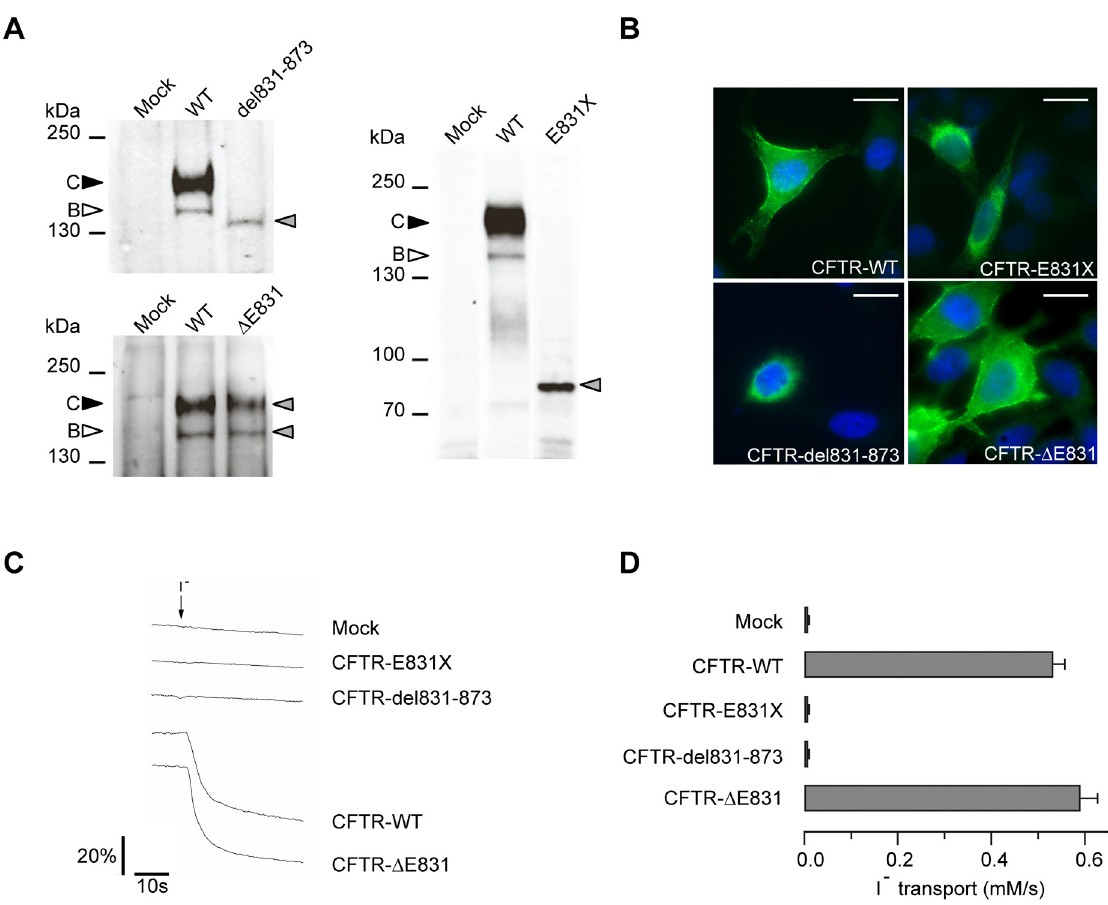
Figure 5. Characterization of the three CFTR mutant proteins. (A) Western blot analysis of HEK293 cells transiently transfected with CFTR-WT, CFTR-del831-873 (upper left panel), or CFTR- D E831 (lower left panel). Western blot analysis of HEK293 cells stably expressing CFTR-WT or CFTR-E831X (right panel). Filled and empty arrowheads indicate the fully-glycosylated (170 kDa) and core-glycosylated (140 kDa) CFTR, respectively. Grey arrowheads indicate mutant proteins. (B) Immunostaining performed on HeLa cells transiently transfected with the indicated constructs. CFTR was stained with MM13-4 anti-CFTR and an AlexaFluor 488 conjugated secondary antibody (green), nuclei were visualized using DAPI (blue). Scale bars: 10 m m. (C) Representative cell fluorescence recordings from HEK293 cells transiently expressing the halide-sensitive YFP (scale bar reports the percentage of total cell fluorescence). Extracellular addition of I 2 (arrow) caused YFP quenching with a rate proportional to the rate of I 2 influx and CFTR activity. (D) Summary of data obtained from the functional assay reporting rates of I 2 transport for the indicated constructs in HEK293 cells. The bars report the transport of iodide as determined from the maximal rate of cell fluorescence decrease (mean 6 SE, n=8–12).